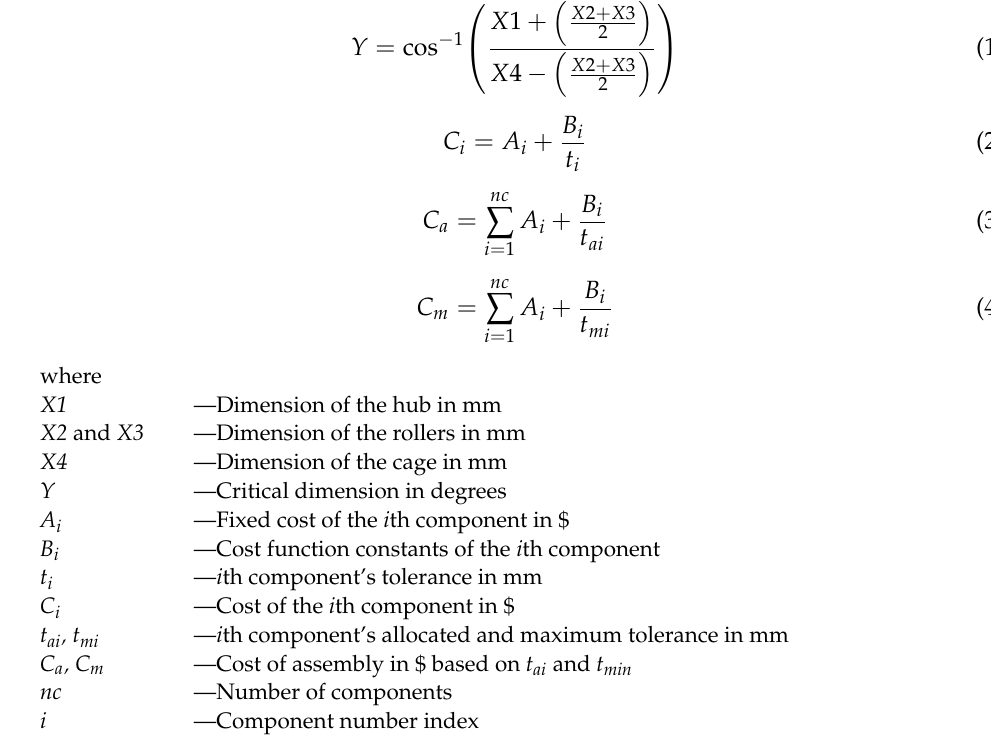
Table 1. Manufacturing details of overrunning clutch assembly. C.No.